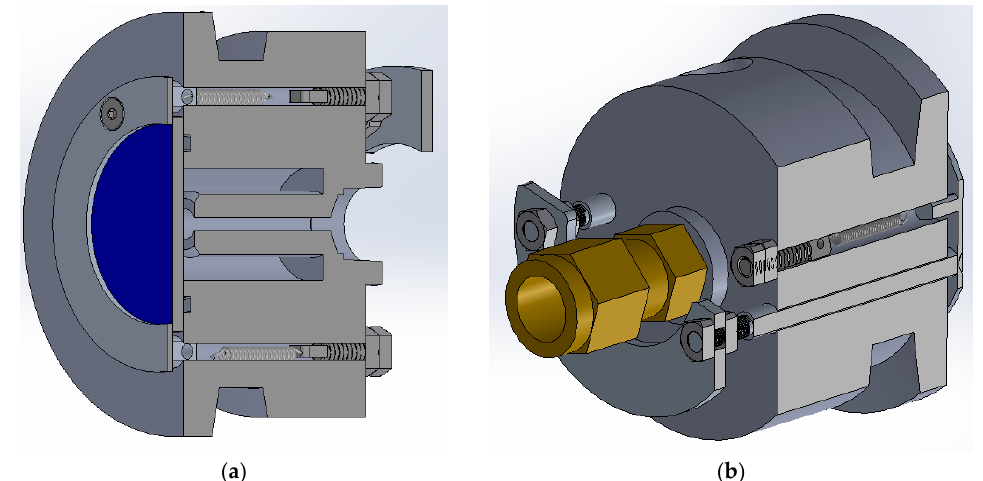
Figure 5. ( a ) Release mechanism (cross-section). ( b ) Release mechanism (side view).